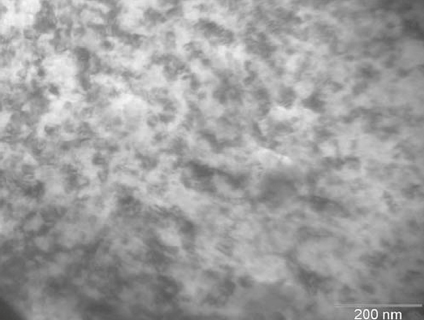
Figure 6: TEM imaging of cold-sprayed nanocrystalline Al 2018 coating [23].